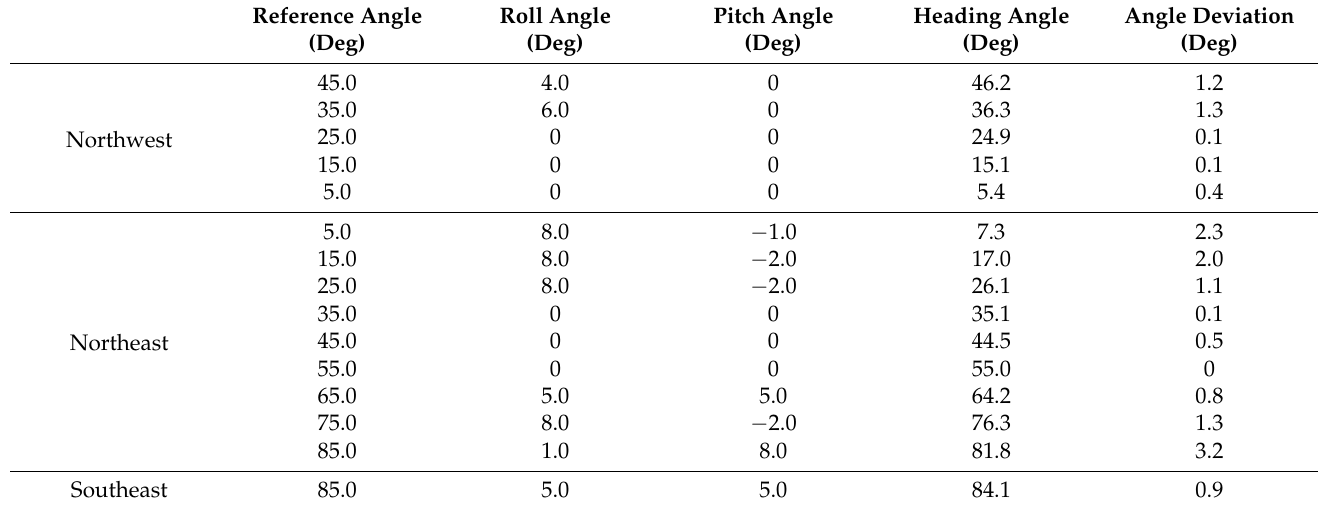
Table 2. Partial comparison between the measurement results of the CFBG-FP sensor for heading angle detection vs. the reference angle.